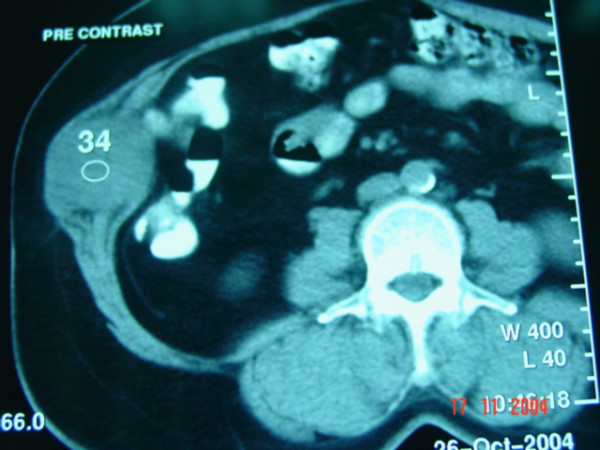
CT-Scan of the abdominal wall, shows the the mass within the abdominal wall muscles in the right hypochondrium with no intrperitoneal extension.